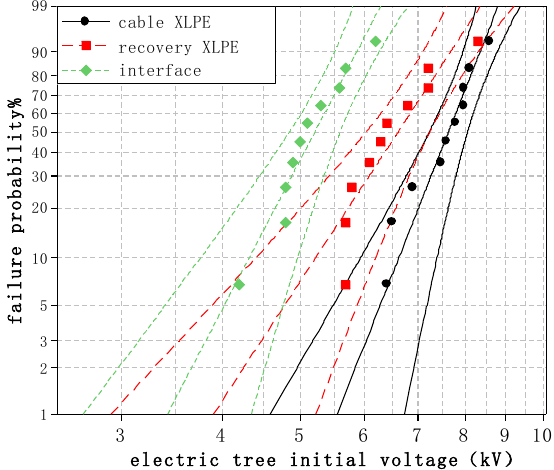
Figure 5. SEM crystalline textures of fractured XLPE ( a ) cable body, ( b ) recovery insulation and ( c ) interface region.